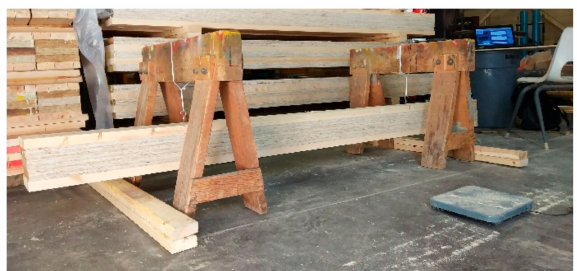
Figure 3. A beam specimen under modal testing.